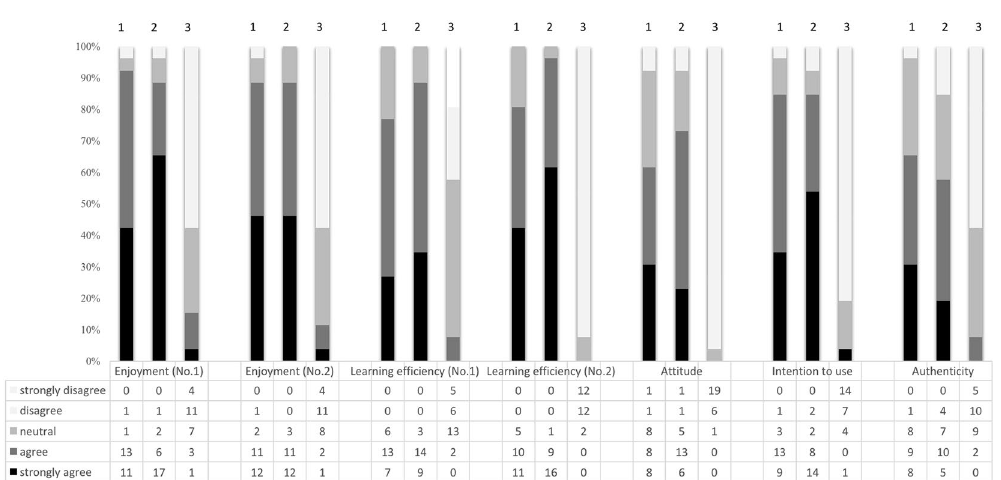
Figure 6. Constitutional ratios of answers to subjective questionnaires. Column 1, 2, and 3 represent cadaveric skulls group, 3D printed skulls group, and atlas group, respectively. The darker the color is, the higher agreement to the statements in questionnaire. Detailed questions of subjective questionnaire shown in Table 1.